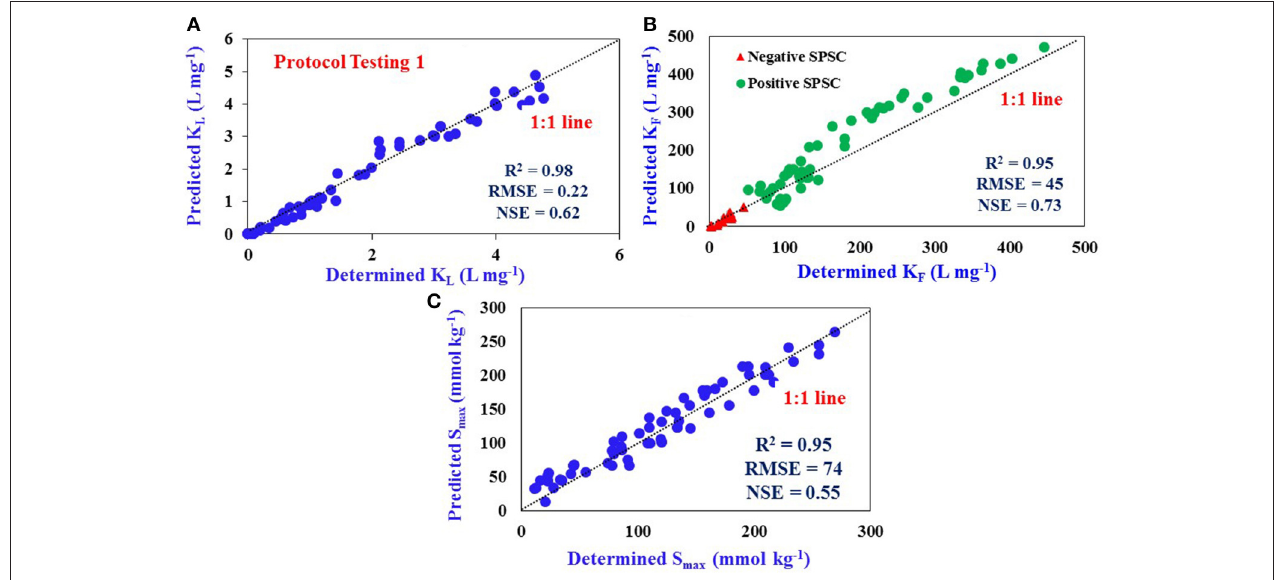
FIGURE 4 | Comparison of determined and predicted values: (A) Langmuir K L ( R 2 = 0.98 ), (B) Freundlich K F ( R 2 = 0.95 ), and (C) P Sorption Maximum, S max ( R 2 = 0.95 ) for Sites 5–7 using predictive equations developed from Sites 1–4 data. Dotted line represents 1:1 linear correlation. The number of samples used for Protocol Testing 1 is 66 ( n = 66 ). The data represent samples from all three